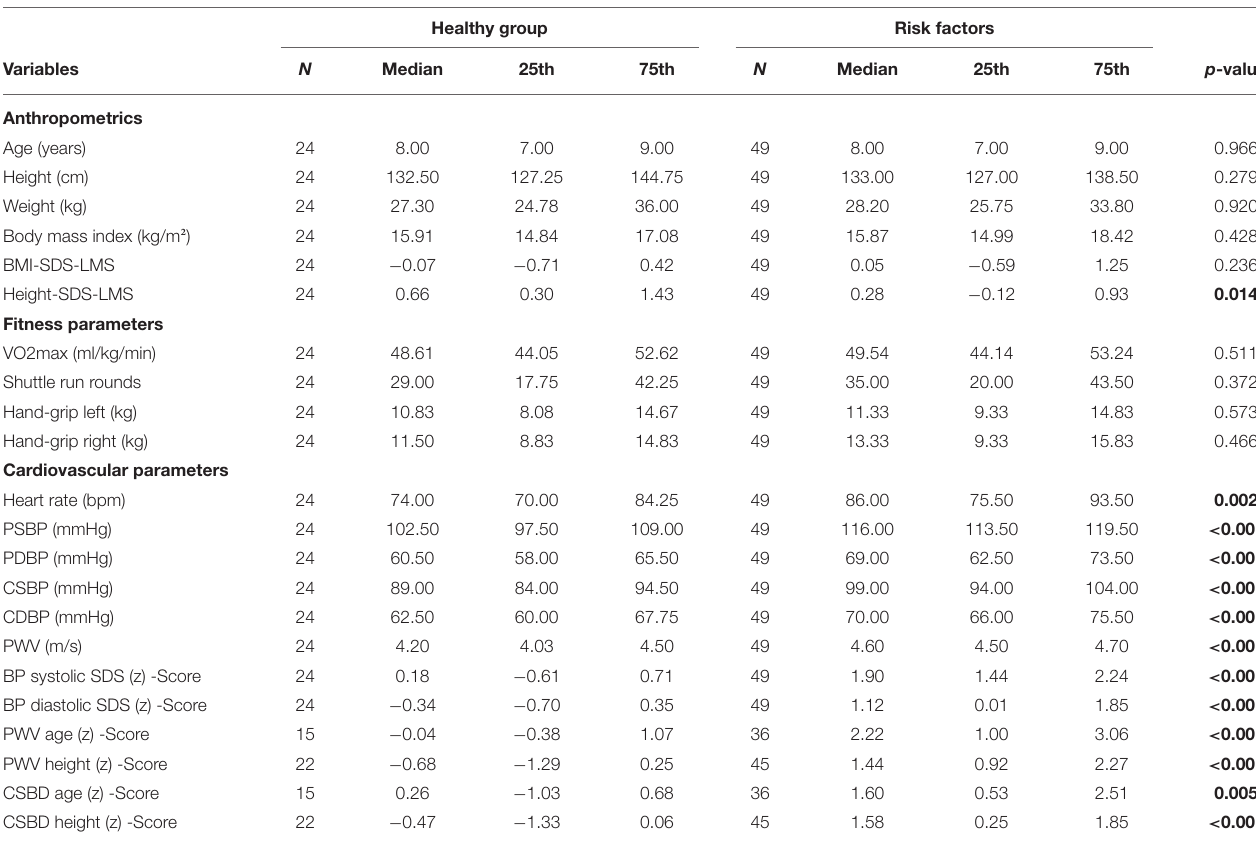
P < 0.05 are shown in bold. Differences were testes using Mann-Whitney-U test. BMI. body mass index; PSBP. peripheral systolic blood pressure; PDBP. peripheral diastolic blood pressure; CSBP. central systolic blood pressure; CDBP. central diastolic blood pressure; PWV. pulse wave velocity; BP. blood pressure.. The groups did not show significant differences in The healthy control group only consisted of children with anthropometric and fitness status data. For cardiovascular normal blood pressure and normal weight. Table 4 presents the data, several significant differences were characteristics of the sample stratified by risk factors.